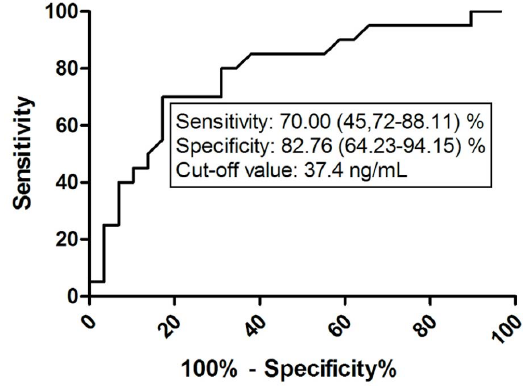
Figure 4. Negative correlation between HA levels and ACT total scores in the asthmatic non-pregnant group. HA – hyaluronic acid; ACT – Asthma Control Test; p=0.01; r= 2 0.437.